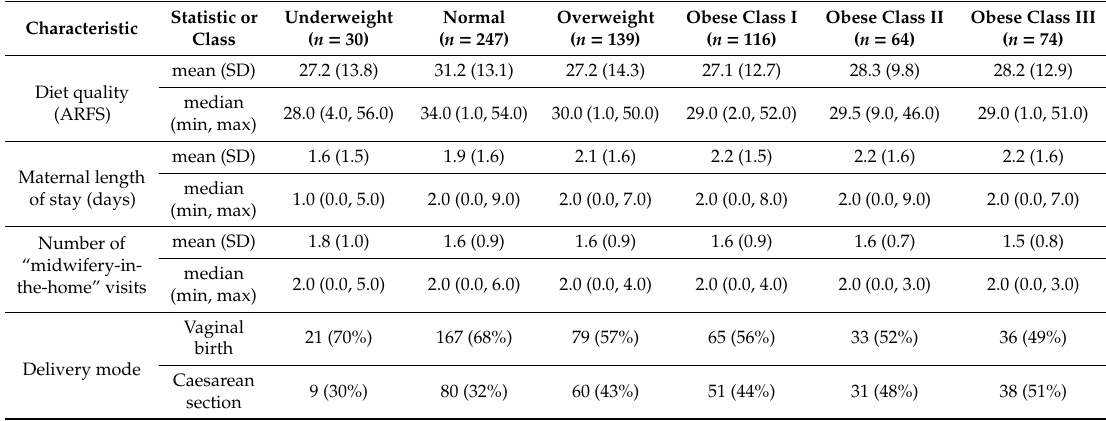
Table 2. Maternal-diet quality, measured using the Australian Recommended Food Score (ARFS), and specific healthcare-resource use by BMI category ( N = 670).